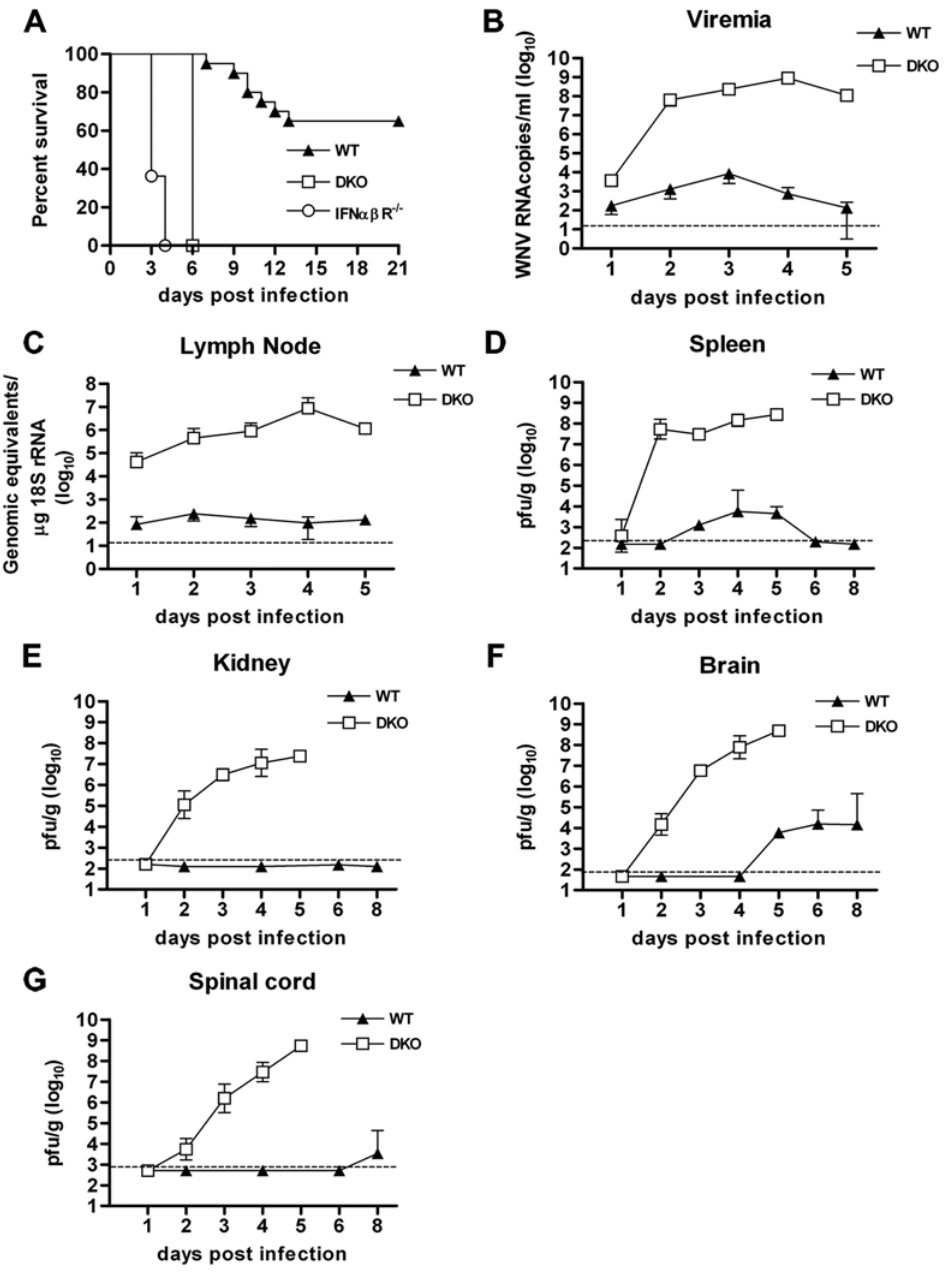
Figure 1. Survival and viral burden analysis in mice. A . Eight to 12 week-old C57BL/6 mice were inoculated with 10 2 PFU of WNV by footpad injection and followed for mortality for 21 days. Survival differences were statistically significant between immunodeficient and wild type mice (n=11, IFN- ab R 2 / 2 ; n=20, DKO; and n=20, wild type mice, P , 0.0001). Average survival time between IFN- ab R 2 / 2 (3.5 days) and DKO (6 days) mice was also statistically different (P , 0.001). B–G . Viral burden in peripheral and CNS tissues after WNV infection. WNV RNA in ( B ) serum and ( C ) draining lymph node, and infectious virus in ( D ) spleen, ( E ) kidney, ( F ) brain and ( G ) spinal cord were determined from samples harvested on the indicated days using qRT-PCR ( B and C ) or viral plaque assay ( D–G ). Data is shown as viral RNA equivalents or PFU per gram of tissue for 10 to 12 mice per time point. For all viral load data, the solid line represents the median PFU per gram at the indicated time point, and the dotted line represents the limit of sensitivity of the assay.